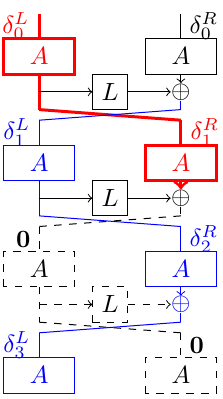
Figure 5: The decomposition into long trails of a truncated trail in a simple